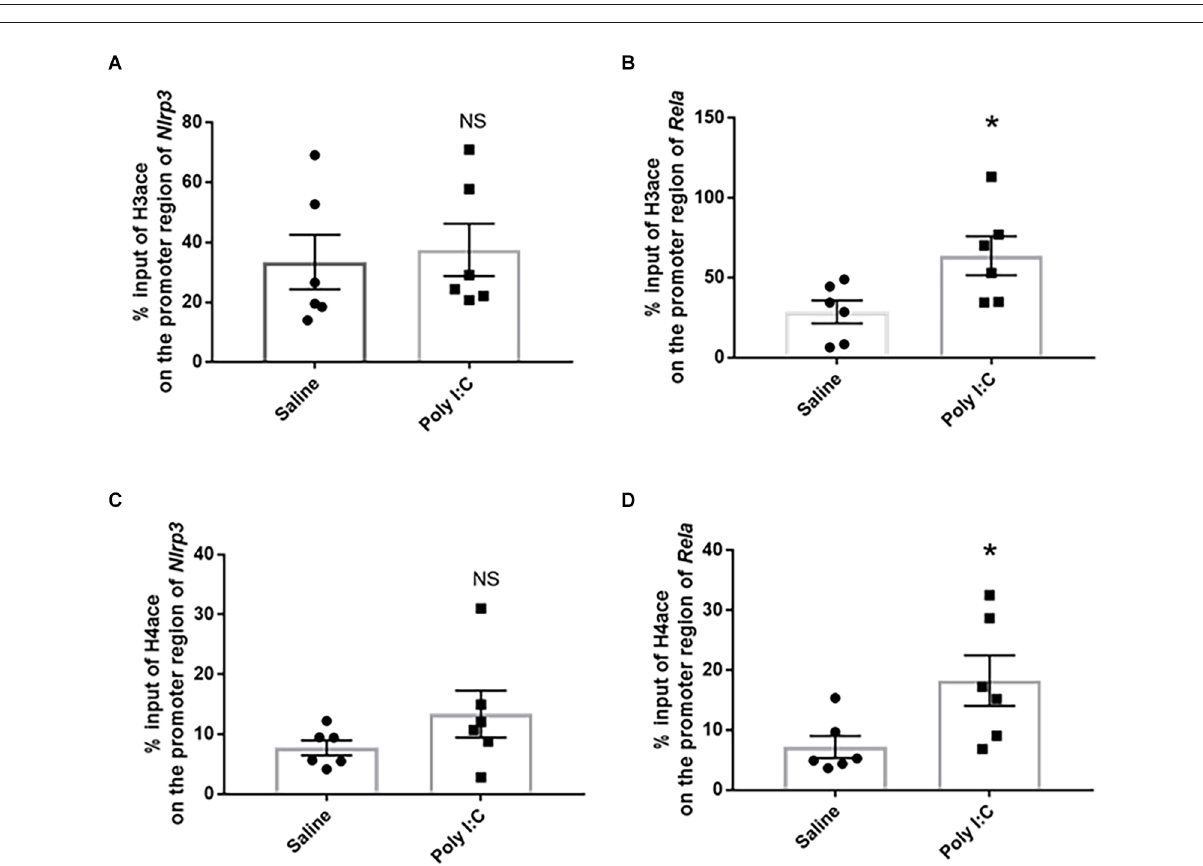
FIGURE2 Histone acetylation on the promoter region of the target genes associated with the NF-kB/NLPR3 pathway. Enrichment of acetylated histone 3 on (A) Nlrp3 and (B) Rela , as well as enrichment of acetylated histone 4 on (C) Nlrp3 and (D) Rela . Data were presented as mean ± SEM ( n = 6/group). NS, no significance; * p < 0.05, Poly I:C vs.